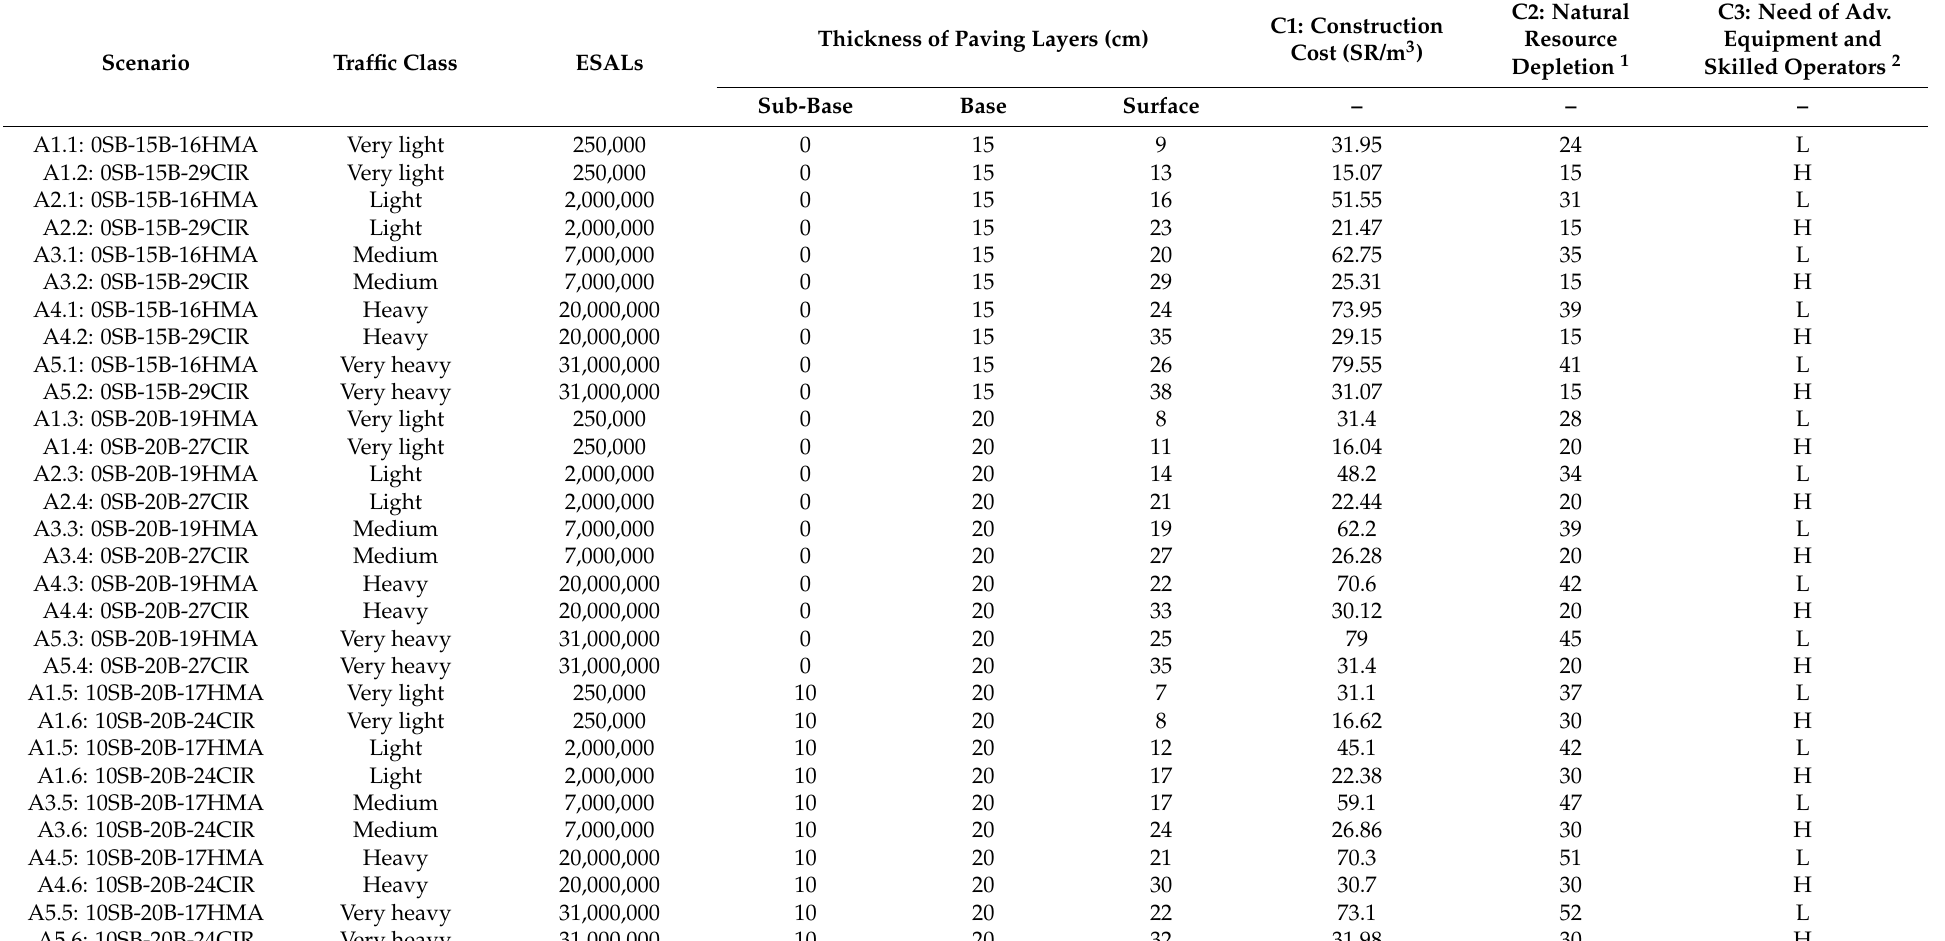
Table 3. Pavement Structure of HMA and CIR